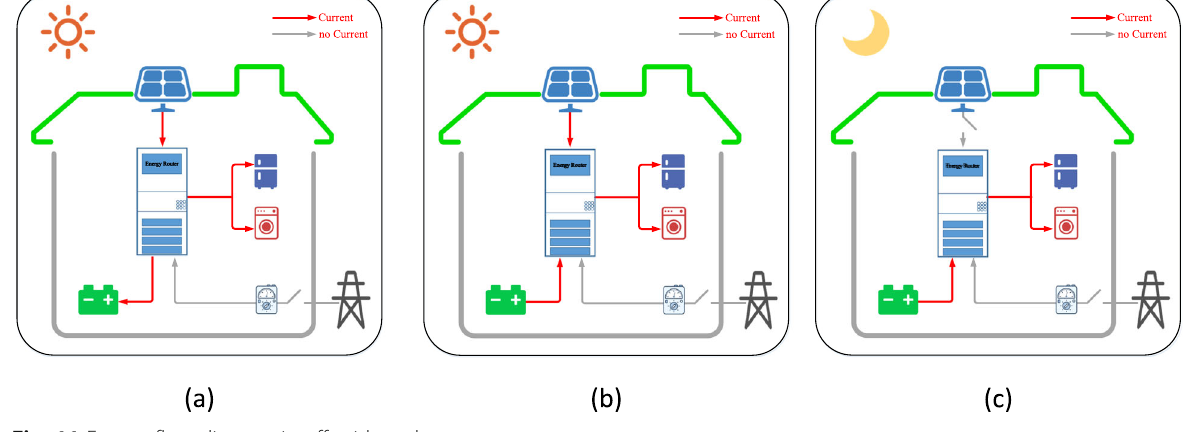
Fig. 11 Energy flow diagram in off-grid